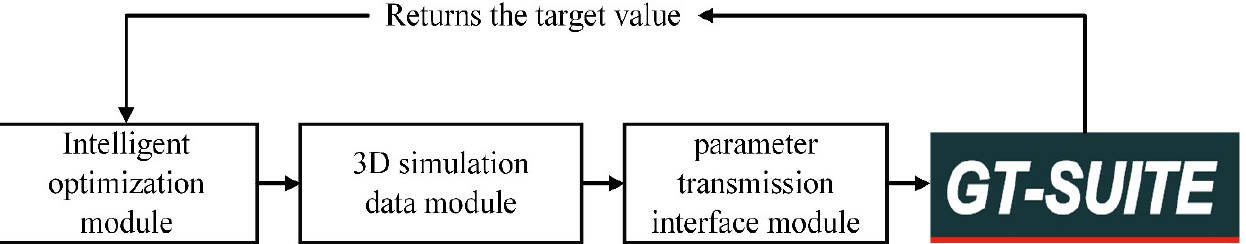
Figure 11. Implementation method of the joint simulation optimization platform.